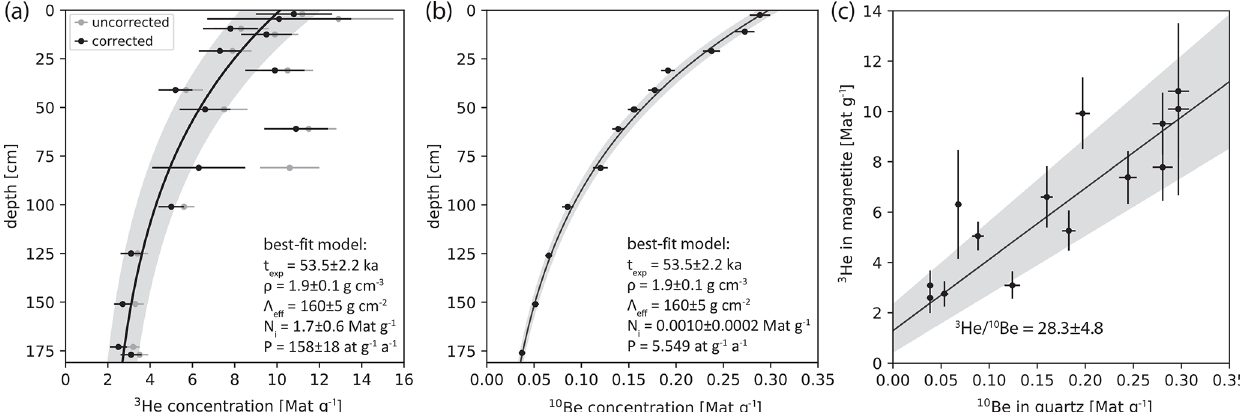
Figure 12. (a) Depth profile of measured 3 He concentrations in magnetite without inclusions corrected for nucleogenic and CTN-produced 3 He with 2 σ uncertainties. Uncorrected data are shown in gray. The solid line and shaded area show the best-fit model with 2 σ uncertainty using a known exposure age t exp , bulk density ρ , and effective attenuation length (cid:51) eff . The model was optimized for the inherited concen- tration N i and the local surface production rate P . Replicate analyses at the same depth are shown with a slight vertical offset for clarity. (b) Depth profile of 10 Be measured in quartz (Hofmann, 2019) extracted from the same samples as the magnetite studied here. The best-fit model uses the same parameters as in (a) , but was optimized for the exposure age and inherited concentration, with a scaled surface 10 Be production rate from the CRONUS-Earth online calculator (Balco et al., 2008). This measurement establishes the surface exposure age used to calibrate the production rate in magnetite. (c) Determination of the 3 He / 10 Be production ratio using data from the depth profiles. 10 Be concentrations were corrected for decay according to Blard et al.